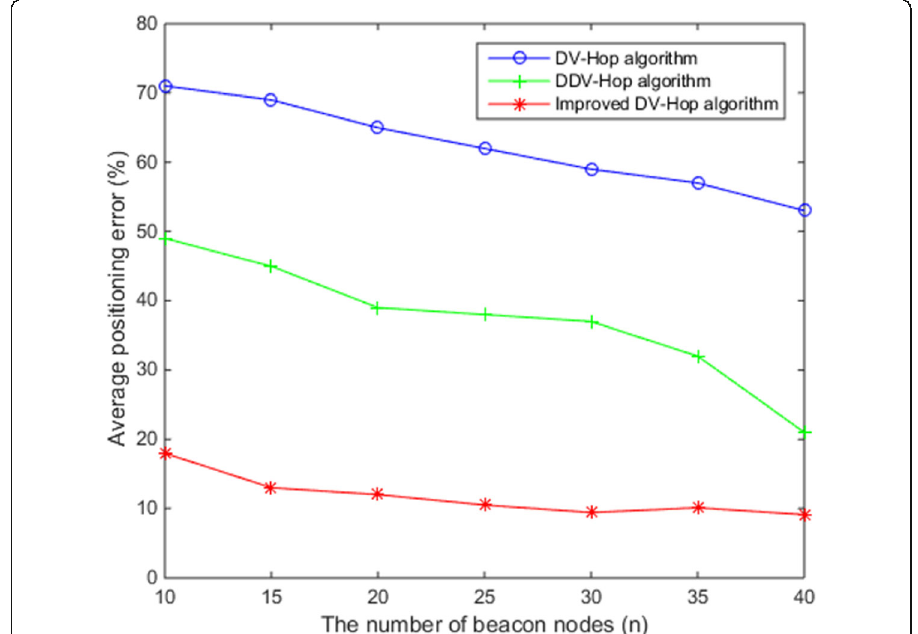
Fig. 8 The influence diagram of beacon node number changes on positioning accuracy